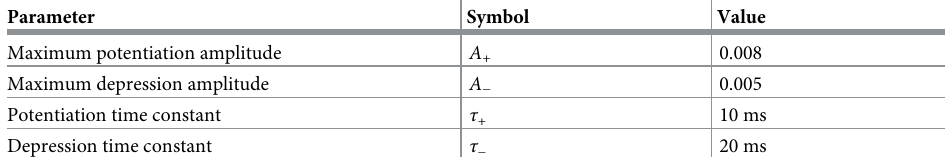
Table 2. Plasticity model parameters [7, 107,